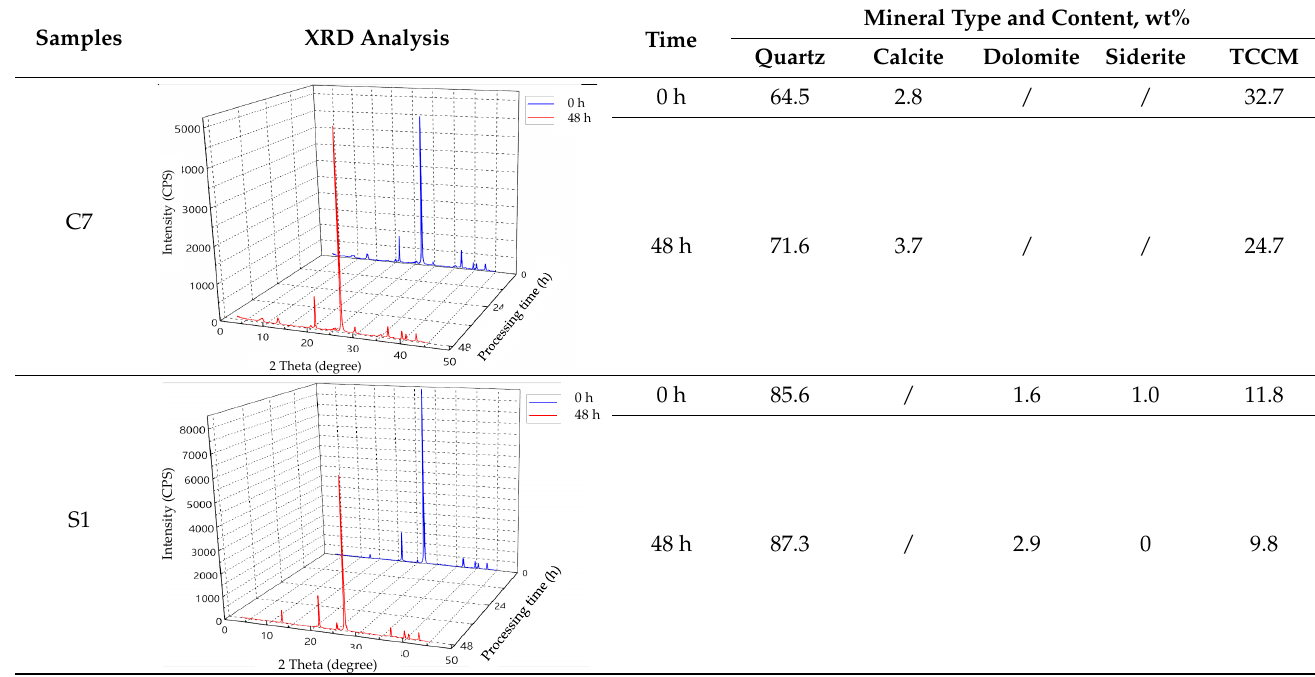
Table 2. Mineral types and contents analyzed by XRD.